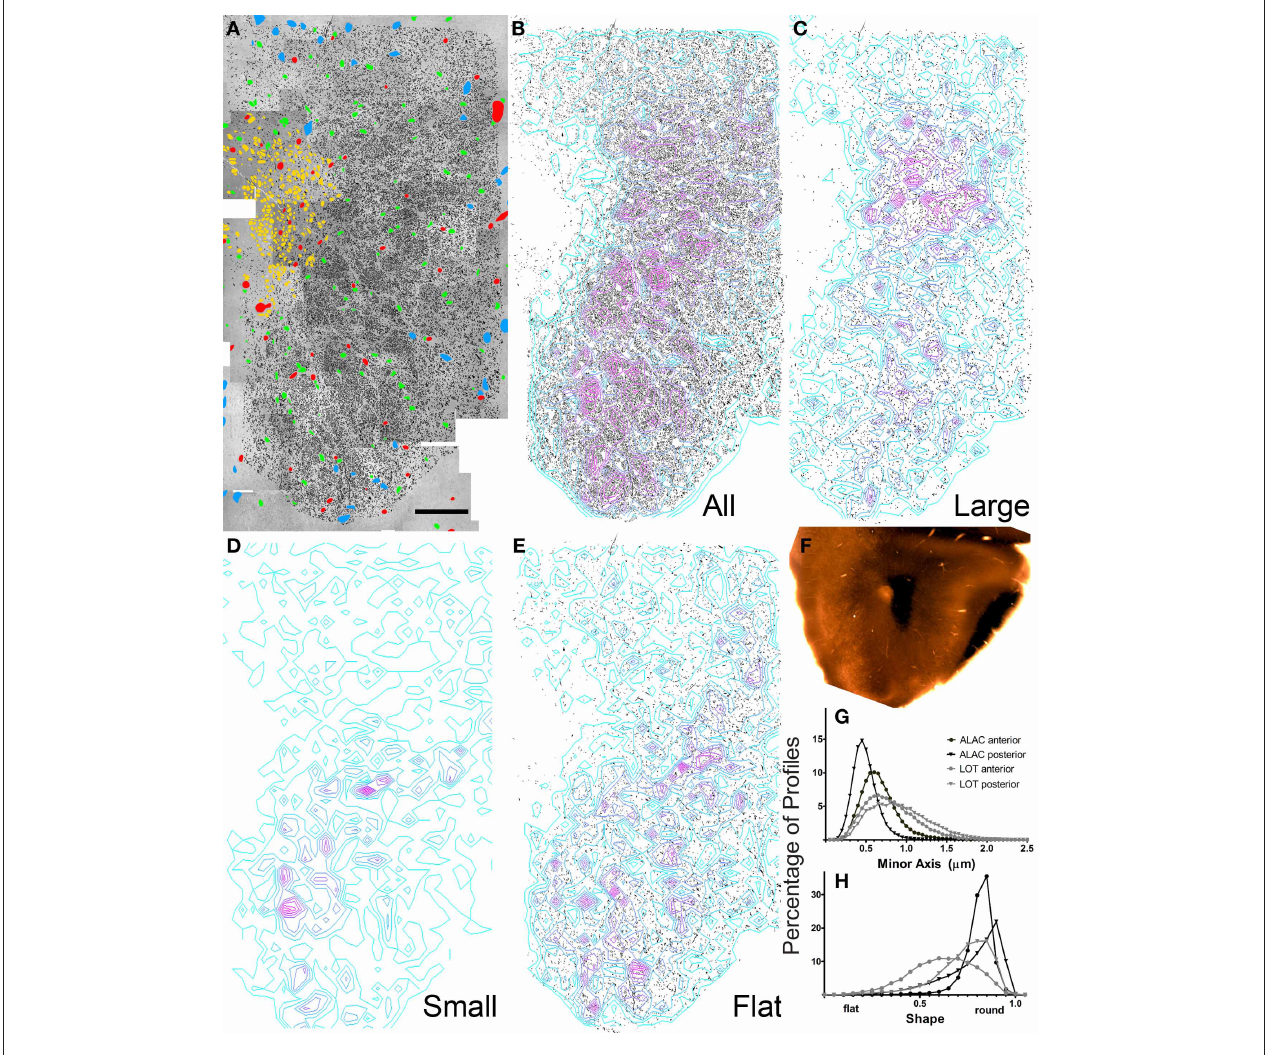
FIGURE 5 | Results of electron microscopic study of myelinated axons in the posterior olfactory peduncle. (A–F) See previous figure for details. (G,H) Comparison of the percentage of